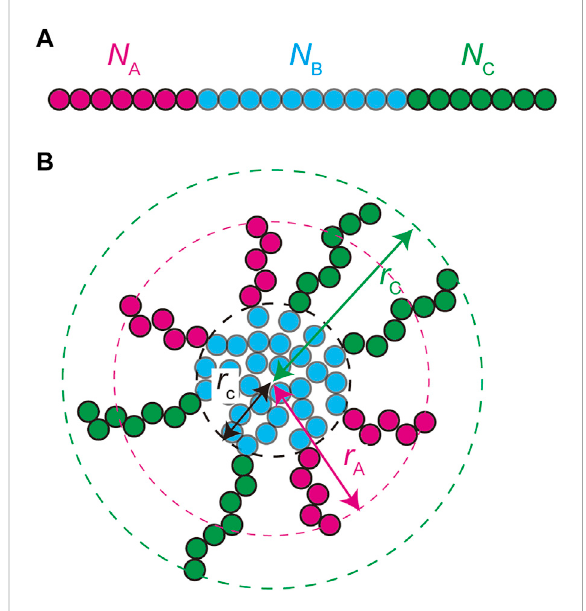
A spherical paraspeckle is modeled as a micelle of ABC block copolymers. The A, B, and C blocks are composed of N A , N B , and (A) . Each paraspeckle is composed of n N C units, respectively copolymers. The B blocks of the copolymers are packed in the core of the paraspeckle and the C blocks are localized in the shell (B) .A fraction α oftheA blocks is localized attheshelland the other fraction is in the core. The A and C blocks are located in distinct domains in the shell. The size of the paraspeckle is characterized by the radius r c of the core, the distance r A between the top of an A domain and the center of the paraspeckle, and the distance r C between the top of a C domain and the center of the